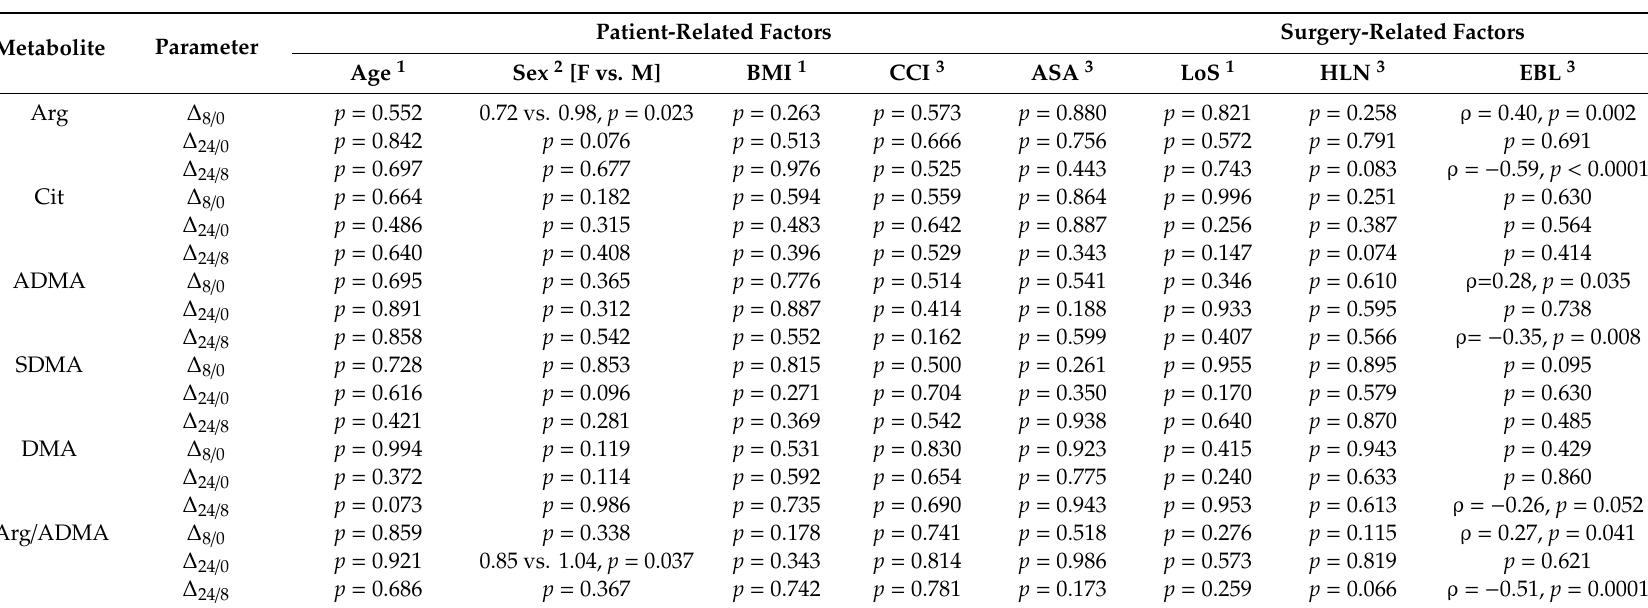
Table 10. Patient-related and surgery-related factors potentially a ff ecting initial time-course in metabolite concentration following colorectal